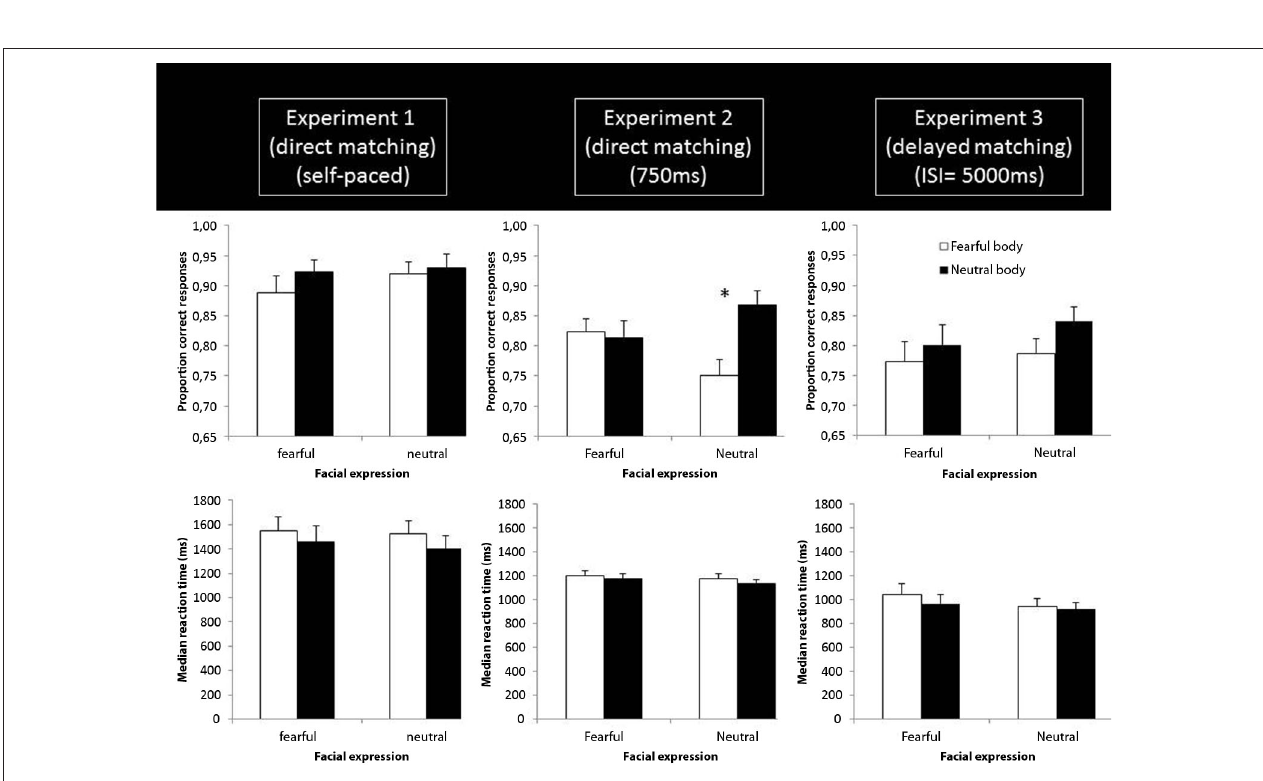
FIGURE 1 | Stimulus examples . Examples of experimental stimuli showing on top a fearful face on a fearful body (A) ; a neutral face on a fearful body (B) ; a fearful face on a neutral body (C) and a neutral face on a neutral body (D) . On the bottom two face identities are